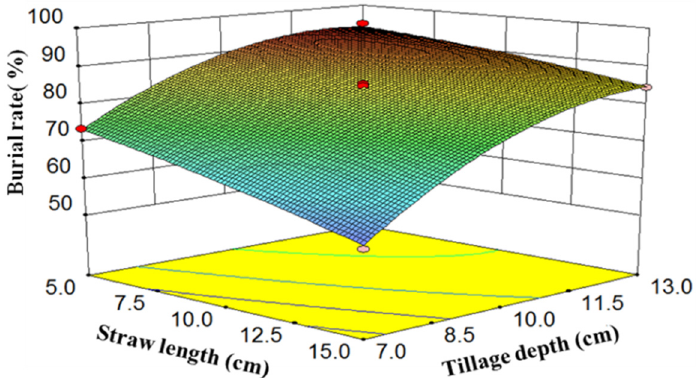
Figure 8. Response surfaces of straw length and tillage depth on straw burial rate.